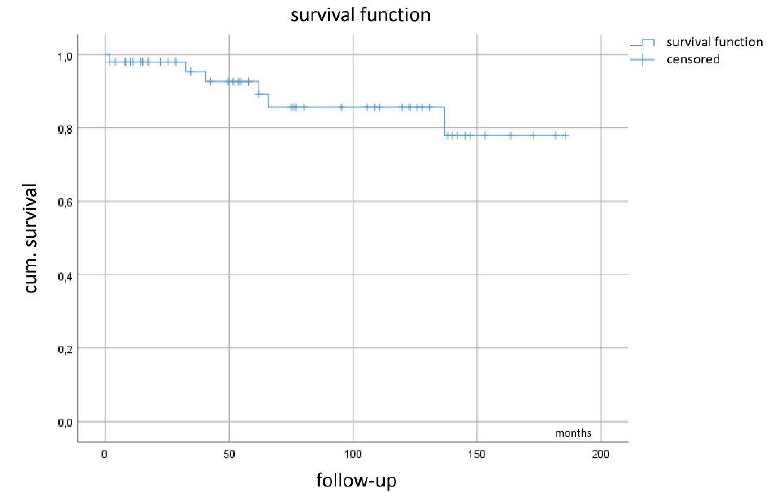
Figure 5. Recurrence-free survival.